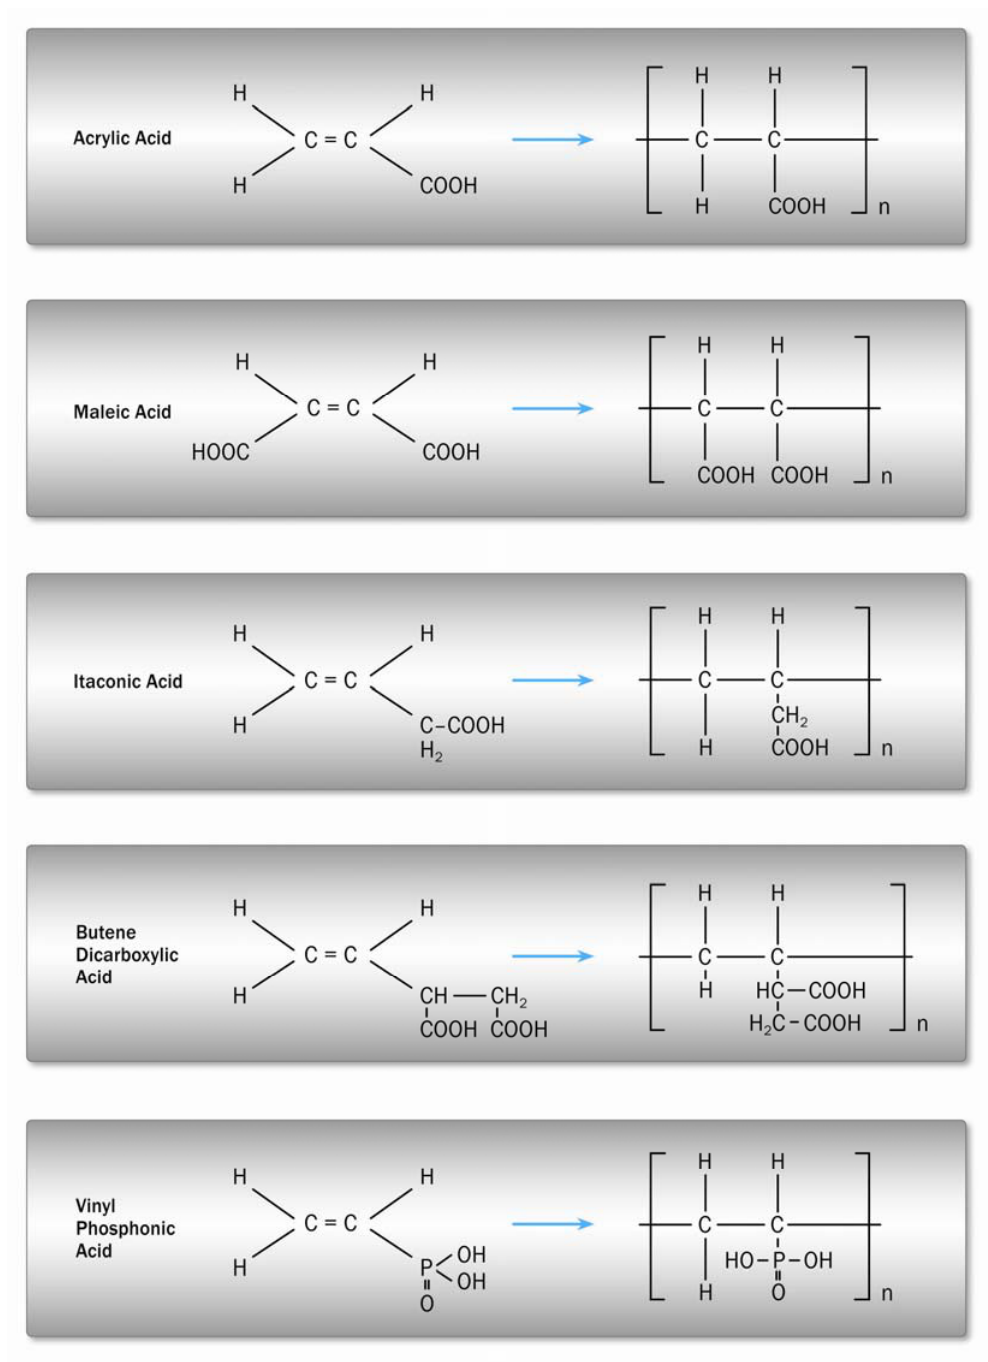
Figure 4. Polycarboxylic acids used for GIC formation